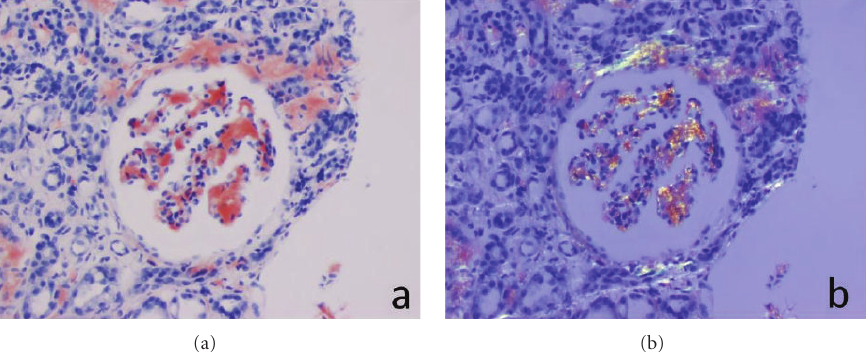
Figure 1: (a) Reddish-orange Congophilic amyloid deposits observed in glomeruli and surrounding interstitium from renal biopsy (b) Congophilic deposits visualized under polarized light demonstrating apple-green birefringence.